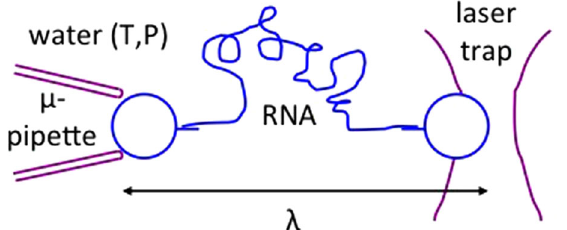
FIG. 1. Schematic depiction of single-molecule setup (not to scale). A molecule of RNA attached to two micron-size beads is immersed in aqueous solution and manipulated using optical tweezers. The work parameter λ denotes the distance from the fixed micropipette to the center of the laser